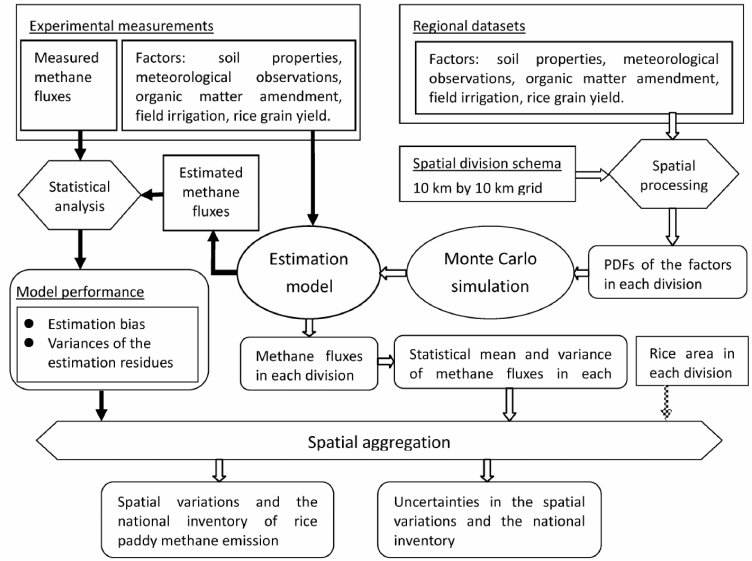
Figure 2. Flowchart for estimating regional and national methane emissions and the uncertainties associated with field measurements and